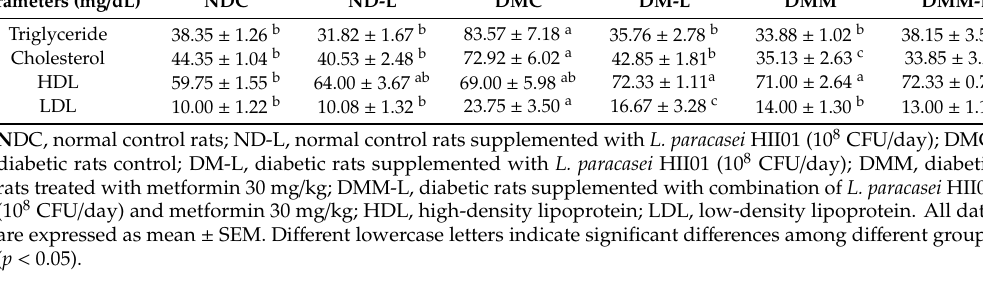
Table 2. E ff ects of L. paracasei HII01 on lipid parameters in experimental groups. Parameters (mg /